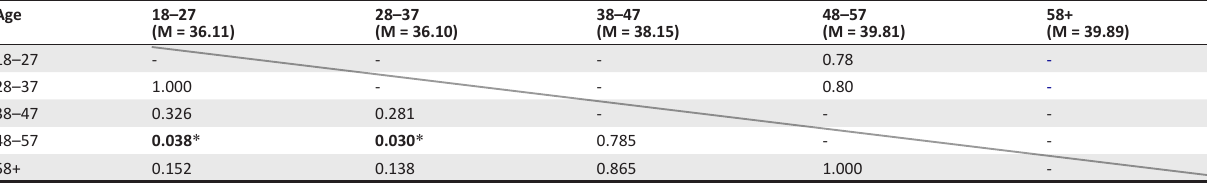
TABLE 5: Tukey tests and Cohen’s d for competence , according to age.